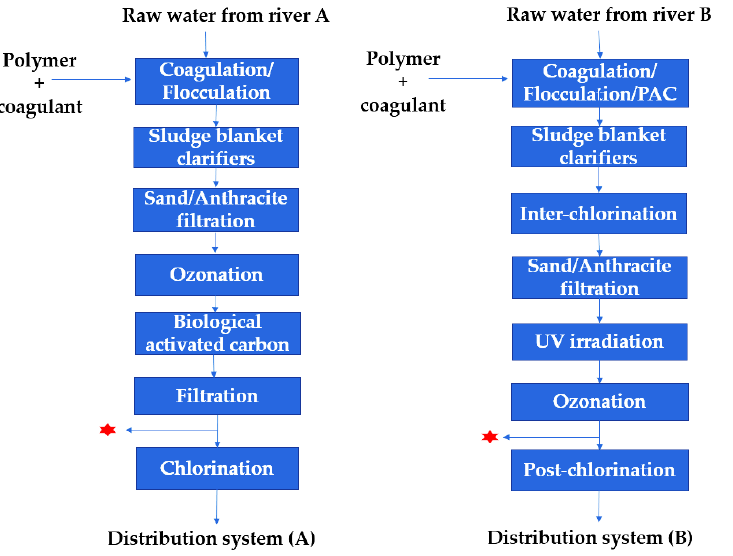
Figure 1. Schematic of the treatment chains for WTPs of City A and City B. The stars indicate the location of the sampling point in each plant. location of the sampling point in each